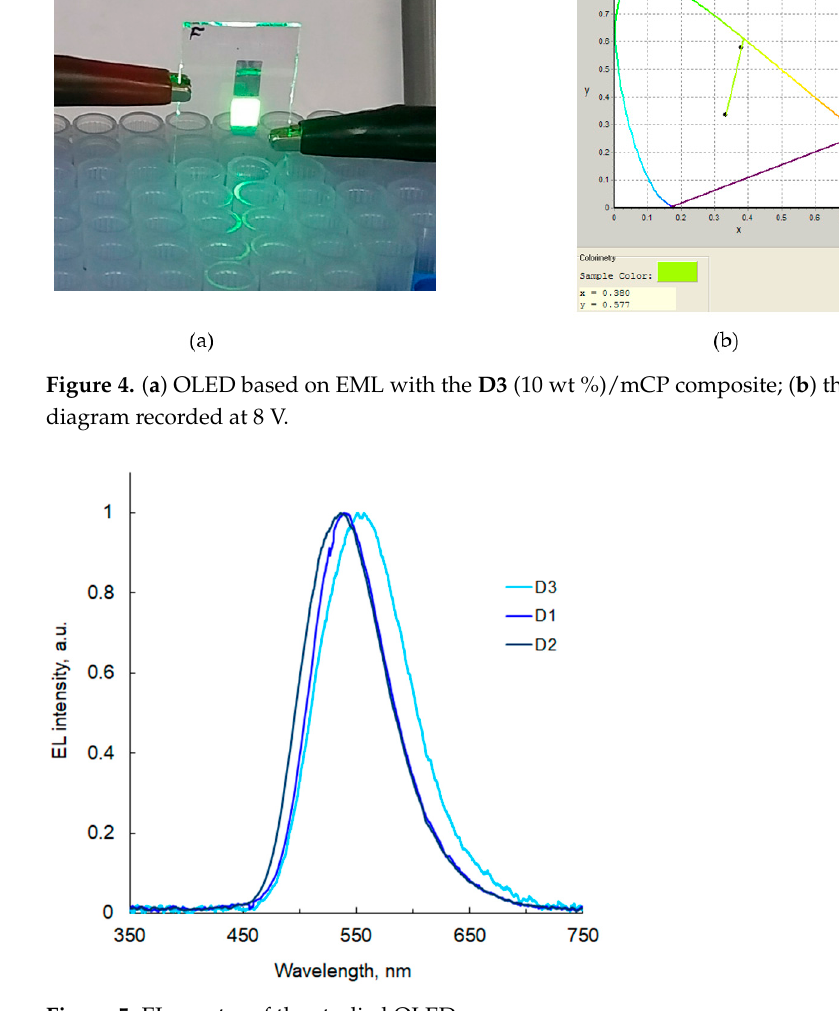
Figure 4. ( a ) OLED based on EML with the D3 (10wt %) / mCP composite; ( b ) the CIE chromaticity diagram recorded at 8V. Table 3. EL characteristics of the studied OLEDs with different light-emitting layers